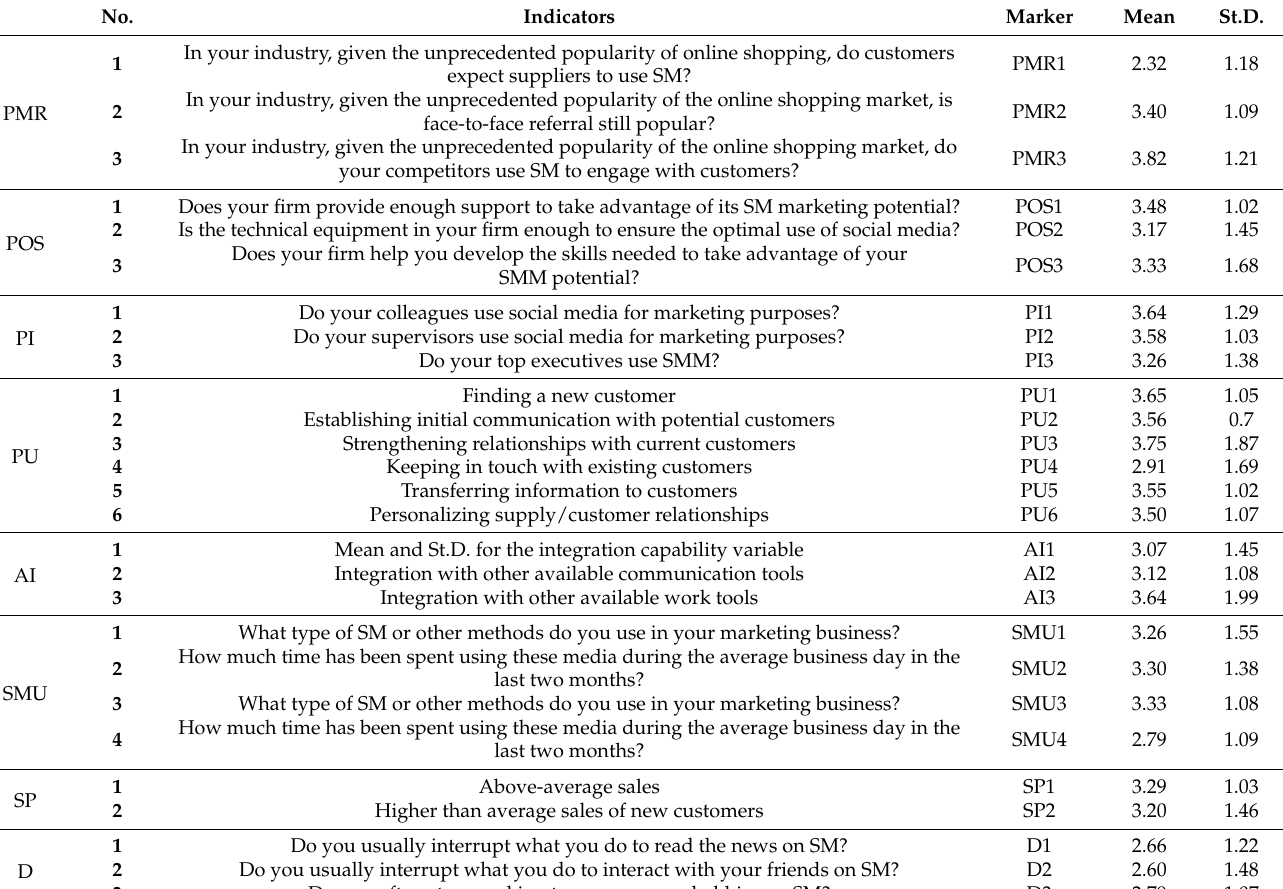
Table 7. The mean and standard deviation for the observed